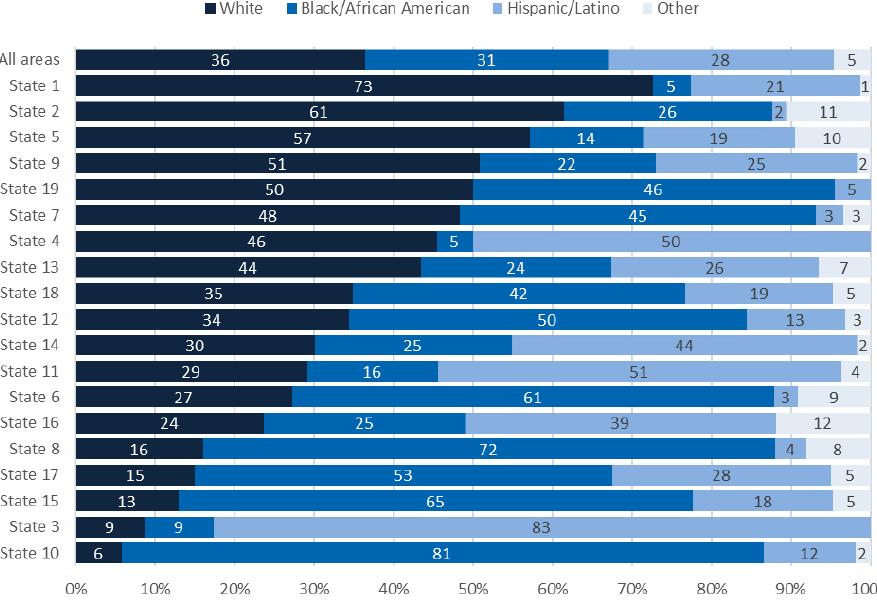
Figure 3. Race/ethnicity of people in clusters of rapid transmission first detected during 2018–2019, overall and in selected states (those with at least 20 cluster members).